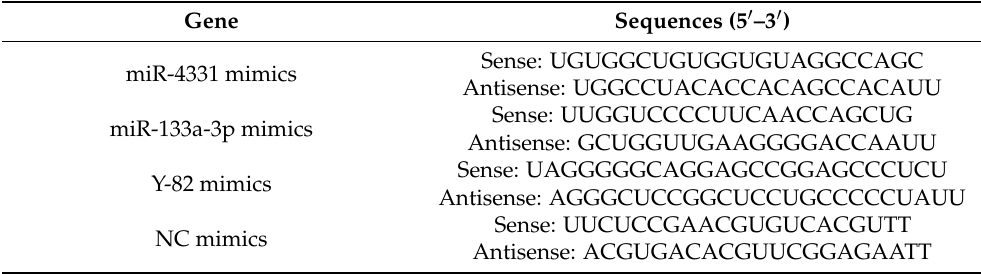
Table 1. Sequences of the miRNA